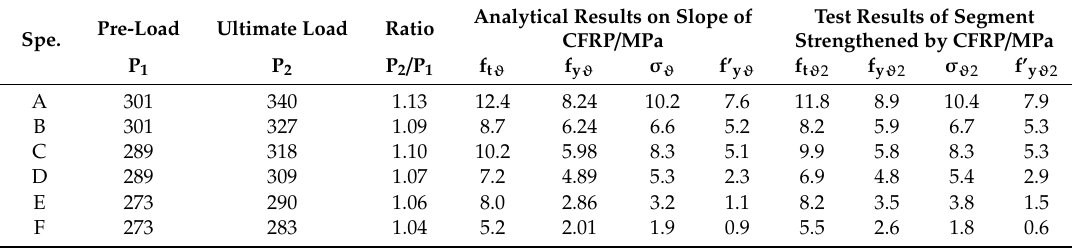
Table 9. Analytical and experimental results of the segment structure and joint under di ff erent humidity values.